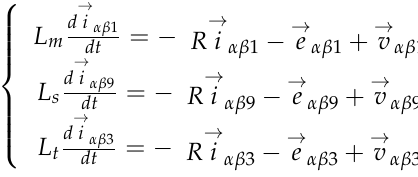
Figure 2. Four fictitious machines and associated harmonic groups of the seven-phase PMSM [33]. The measured back EMF of one phase of the non-sinusoidal seven-phase PMSM and the harmonic spectrum are described in Figure 3. It can be seen that the amplitudes of the 1st, 9th, and 3rd harmonics are highest in the back EMF. By decomposing the seven-phase PMSM into several fictitious machines (see Figures 2 and 3), the 1st, 13th, 15th, and 27th harmonics are associated with the Main Machine (MM); the 9th, 19th and 23rd harmonics with the Secondary Machine (SM); and the 3rd, 11th, and 17th harmonics with the Third Machine (TM). In the same way, the 7th and 21st harmonics are associated with the Ho- mopolar Machine (HM) (homopolar currents are equal to zero with the wye connection). Therefore, the model of a seven-phase PMSM, considering the 1st harmonic in MM, the 9th harmonic in SM, and the 3rd harmonic in TM, can be expressed in the stationary ref- erence frames (